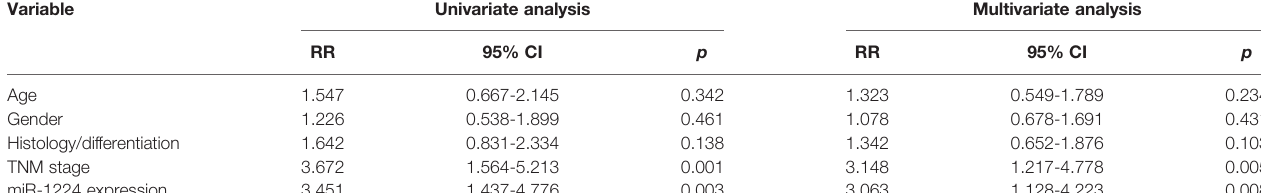
TABLE 3 | Multivariate assays of overall survival and disease-free survival in GC patients. Variable